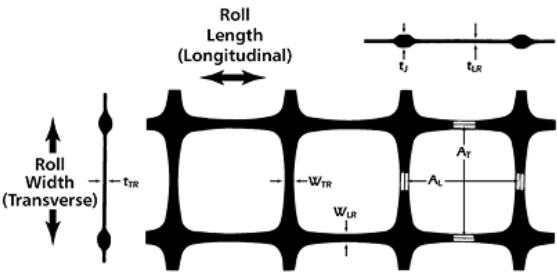
Figure 8. Shape and sizes of geogrid TENSAR SS30.